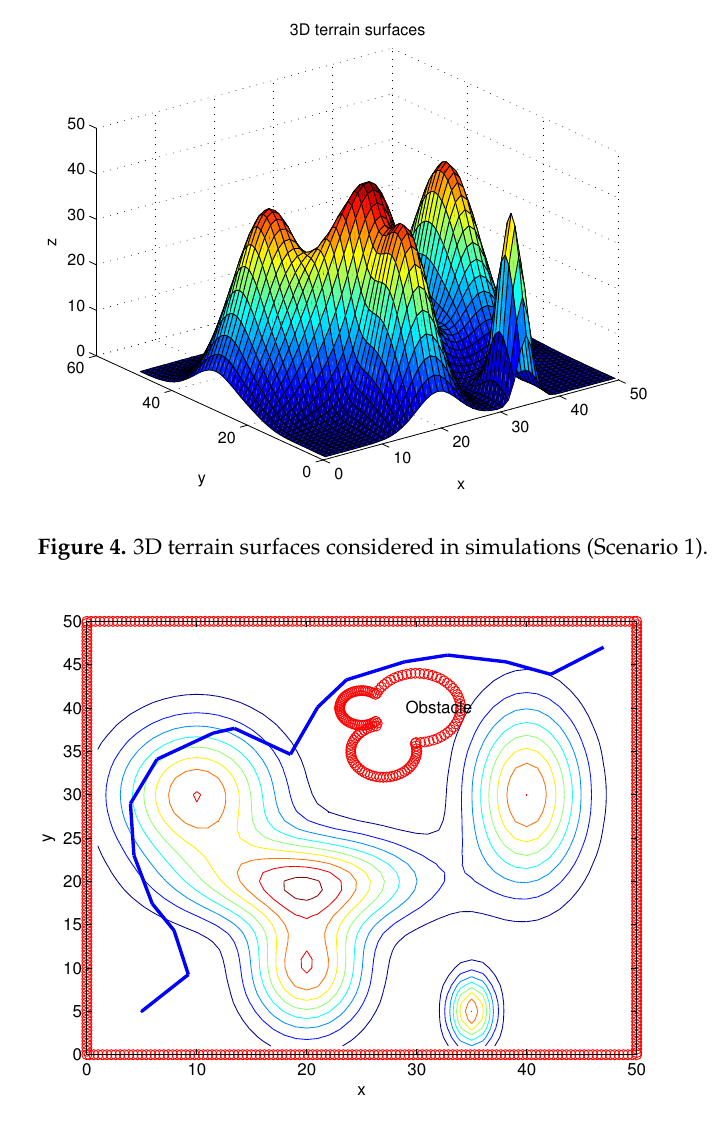
Figure 5. One route constructed under one MC simulation of Algorithm 1 (Scenario 1). A non-convex obstacle is plotted, and we plot the contour map. The route is shown with blue line